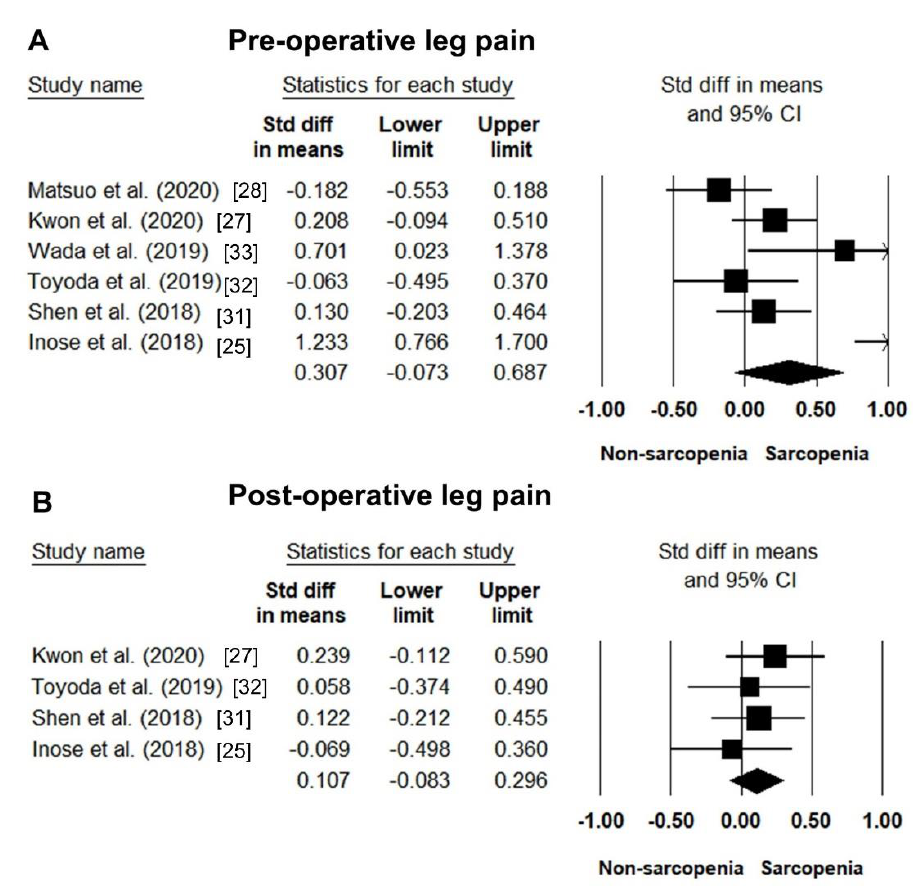
Figure 5. Forest plot of the standardized mean differences of the pre-operative ( A ) and post-operative ( B ) leg pain between patients with and those without sarcopenia.